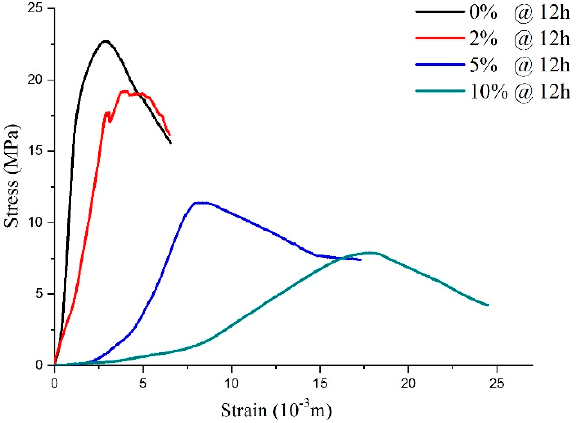
Figure 11. The stress–strain curve for the samples with 12-h curing age under physical sulfate attack with different concentrations.